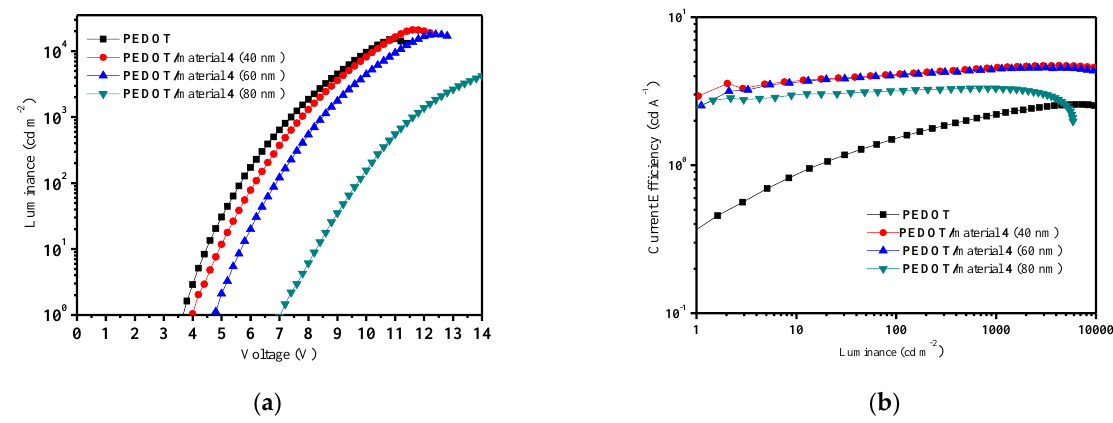
Figure 5. Luminance – voltage (L – V) curves ( a ) and current efficiency – luminance (CE – L) curves ( b ) Figure 5. Luminance–voltage (L–V) curves ( a ) and current efficiency–luminance (CE–L) curves ( b ) of of the devices with the configuration: ITO/ PEDOT /HTL of 4 (40-60-80 nm)/Alq 3 /LiF/Al. the devices with the configuration: ITO/ PEDOT /HTL of 4 (40-60-80 nm)/Alq 3